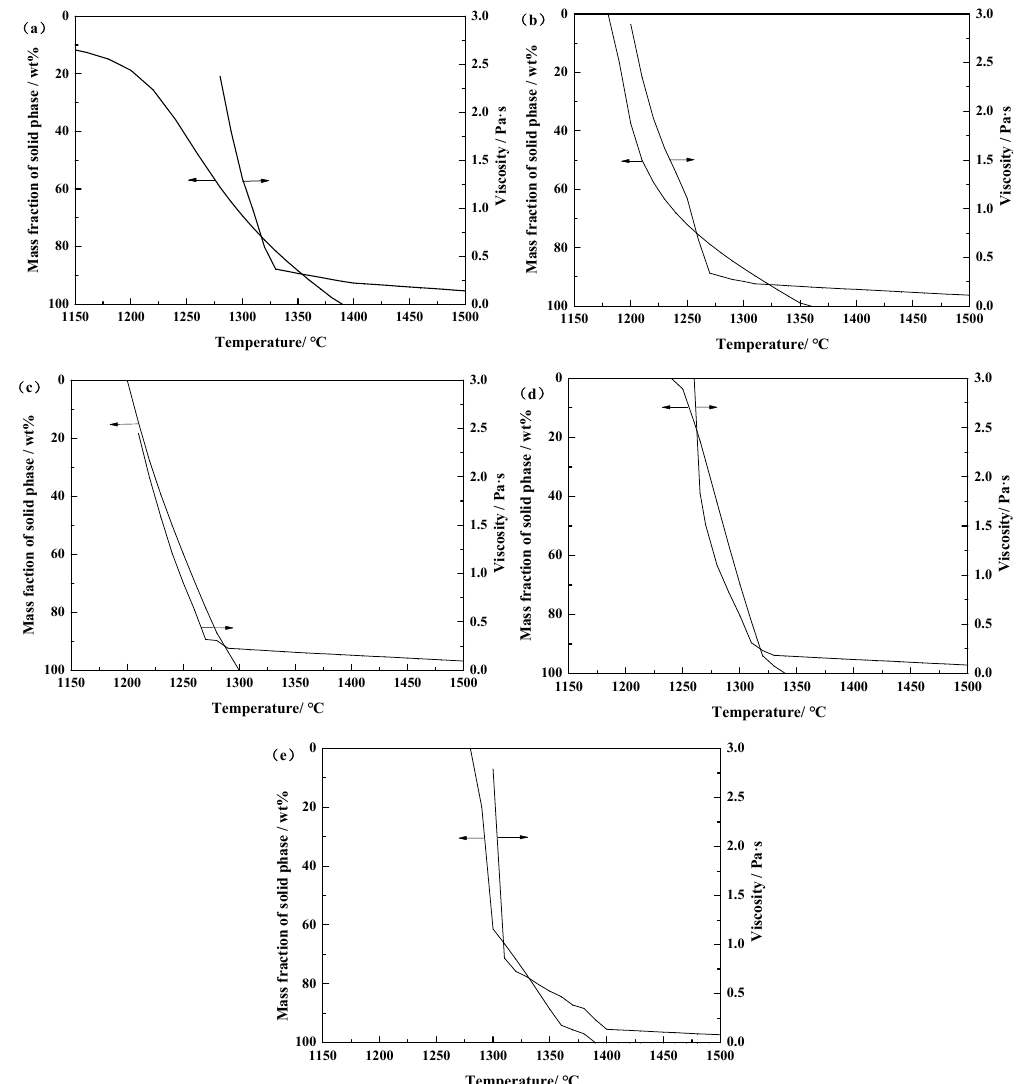
Figure 11. Effect of solid phase precipitation on the viscosity of the CaO-SiO 2 -FeO-MgO system at different basicities: ( a ) R = 0.38; ( b ) R = 0.60; ( c ) R = 0.90; ( d ) R = 1.20; ( e ) R = 1.50.